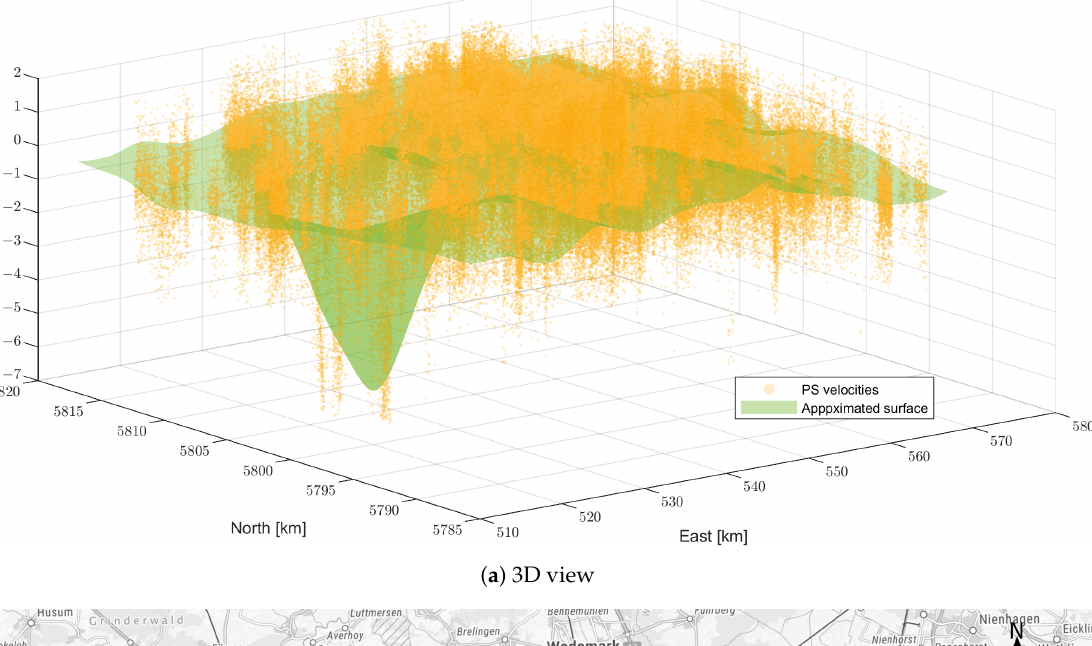
the observed height velocities. In more detail, the approximated RGM is presented in Figure 8b as a color-coded map. Aside from local movements (in the range of ( − 2, 1 ) [mm/year]) to the Earth’s surface, a large movement up to –6 [mm/year] is observed in the left side (area of Wunstorf).